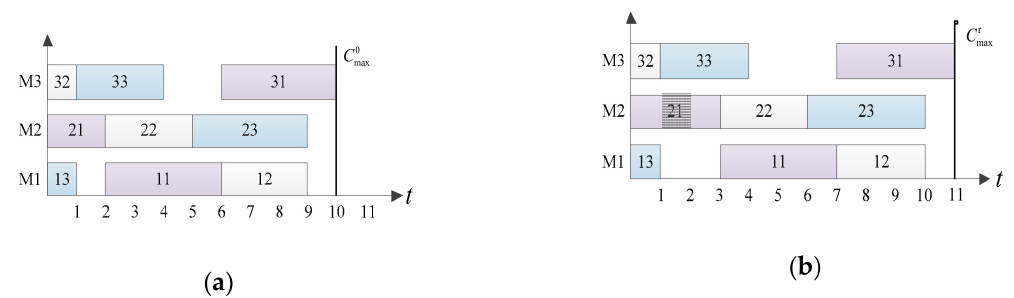
Figure 1. An example for a schedule with 3 machines and 3 jobs under a machine breakdown. ( a ) The schedule before a machine breakdown; ( b ) the schedule after a machine